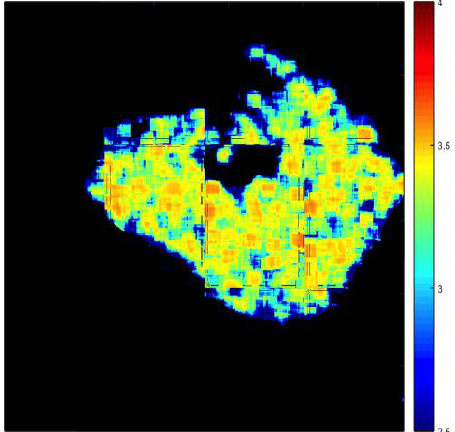
Figure 10. Age map of the floor of crater Tsiolkovsky using the CSFD obtained by the template matching method with an optimal threshold value in combination with the binned SCD